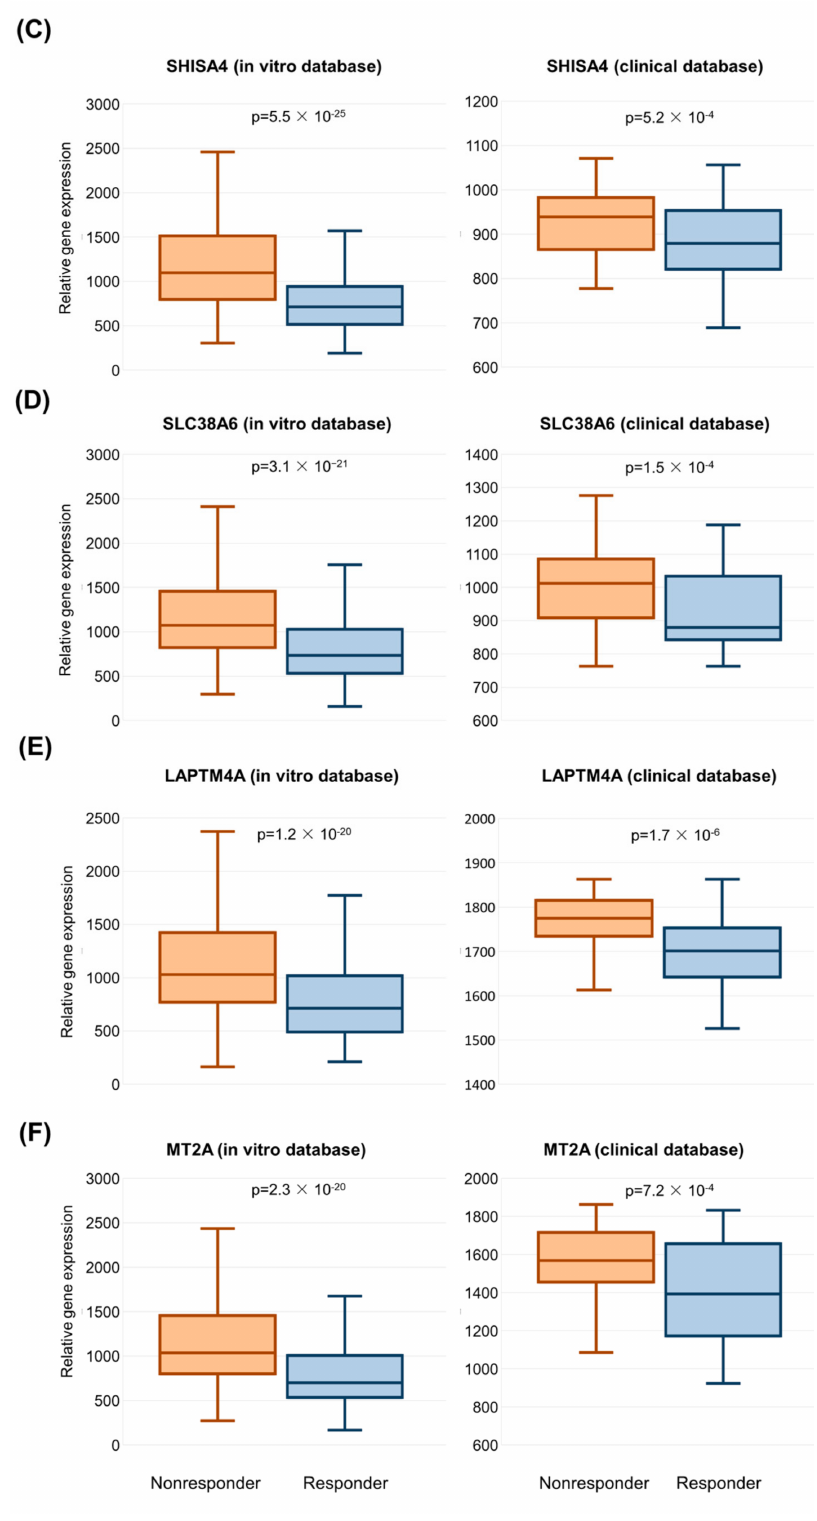
Figure 2. Radar chart of the most significant genes correlated with 5FU therapy response in the in vitro database ( A ) and the human samples ( B ). Boxplots of the most significant genes in both databases ( C – F ). The values presented in the radar chart are ROC AUC values for the specific